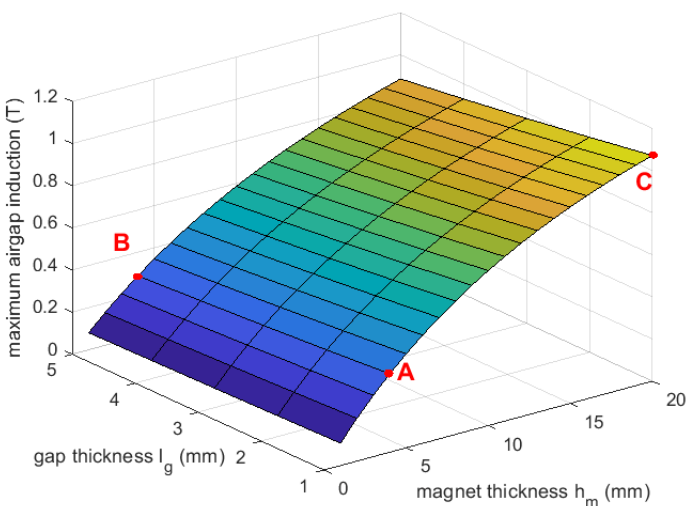
Figure 4. Peak magnetic flux density in the airgap as a function of l g and h m . at a characterstic points A, B and C. Magnetic flux density at points A, B and C is given in Table 2.